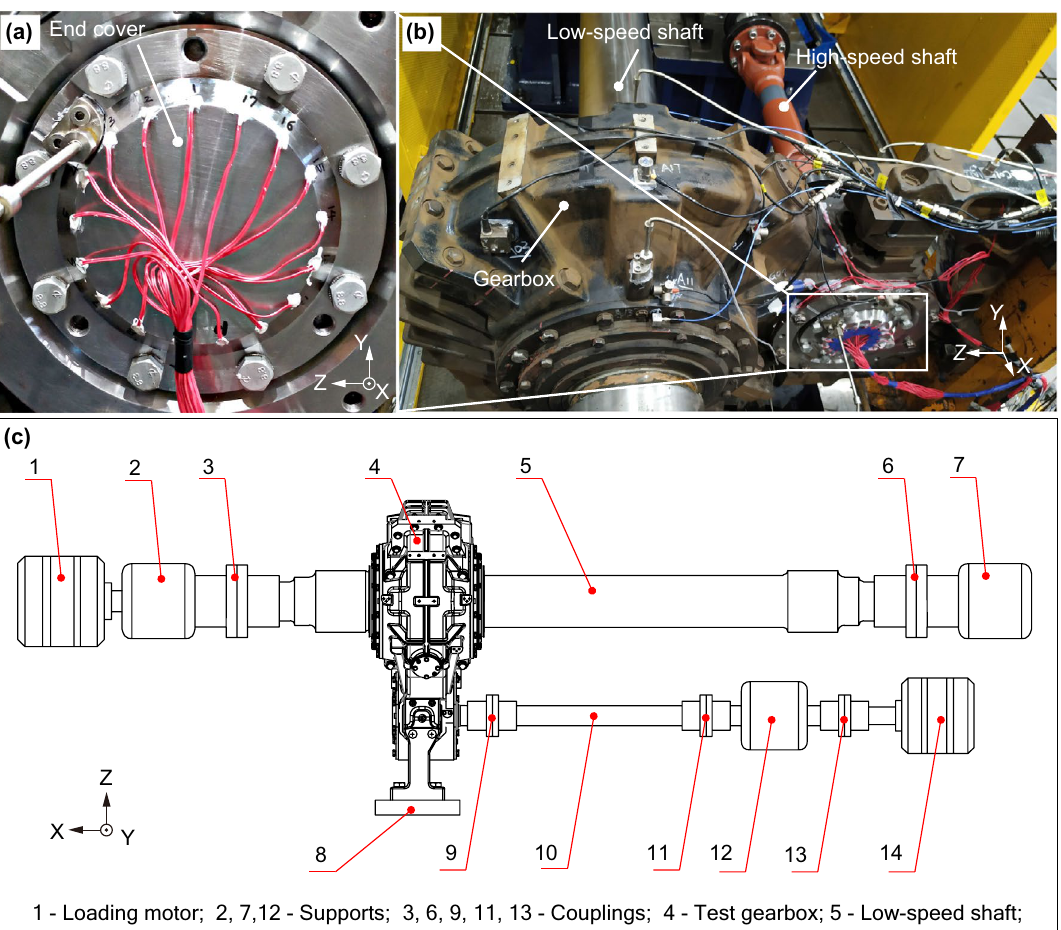
Fig. 5 High-speed train traction system test bench: a layout of the signal cables; b photo of the test bench; c schematic diagram of the test